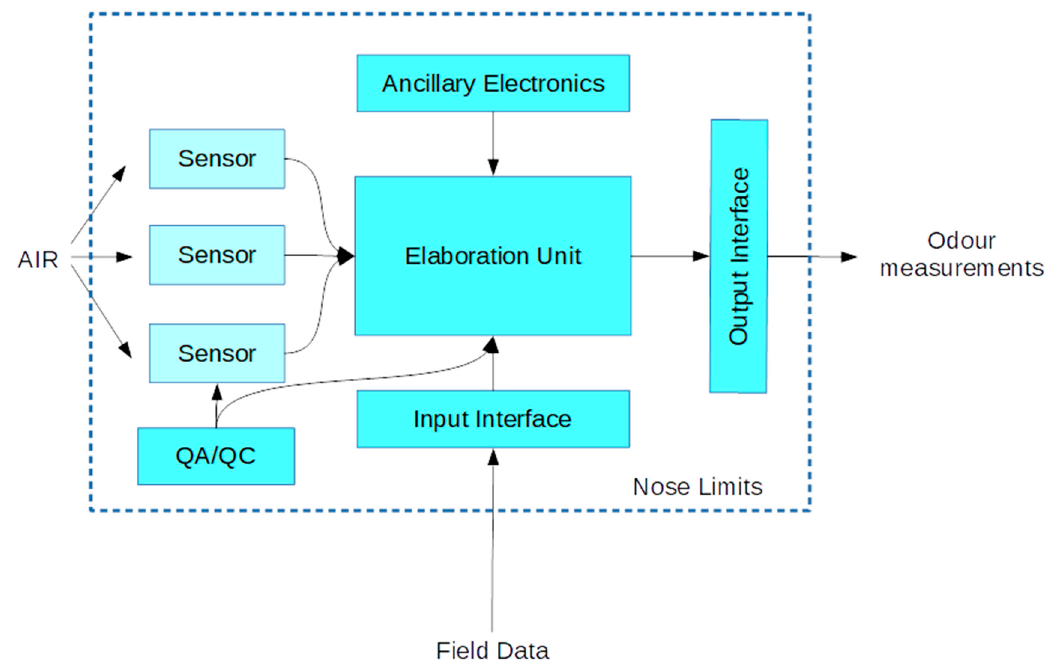
Figure 1. Electronic nose with quality assurance (QA)/QC control of the sensor array.